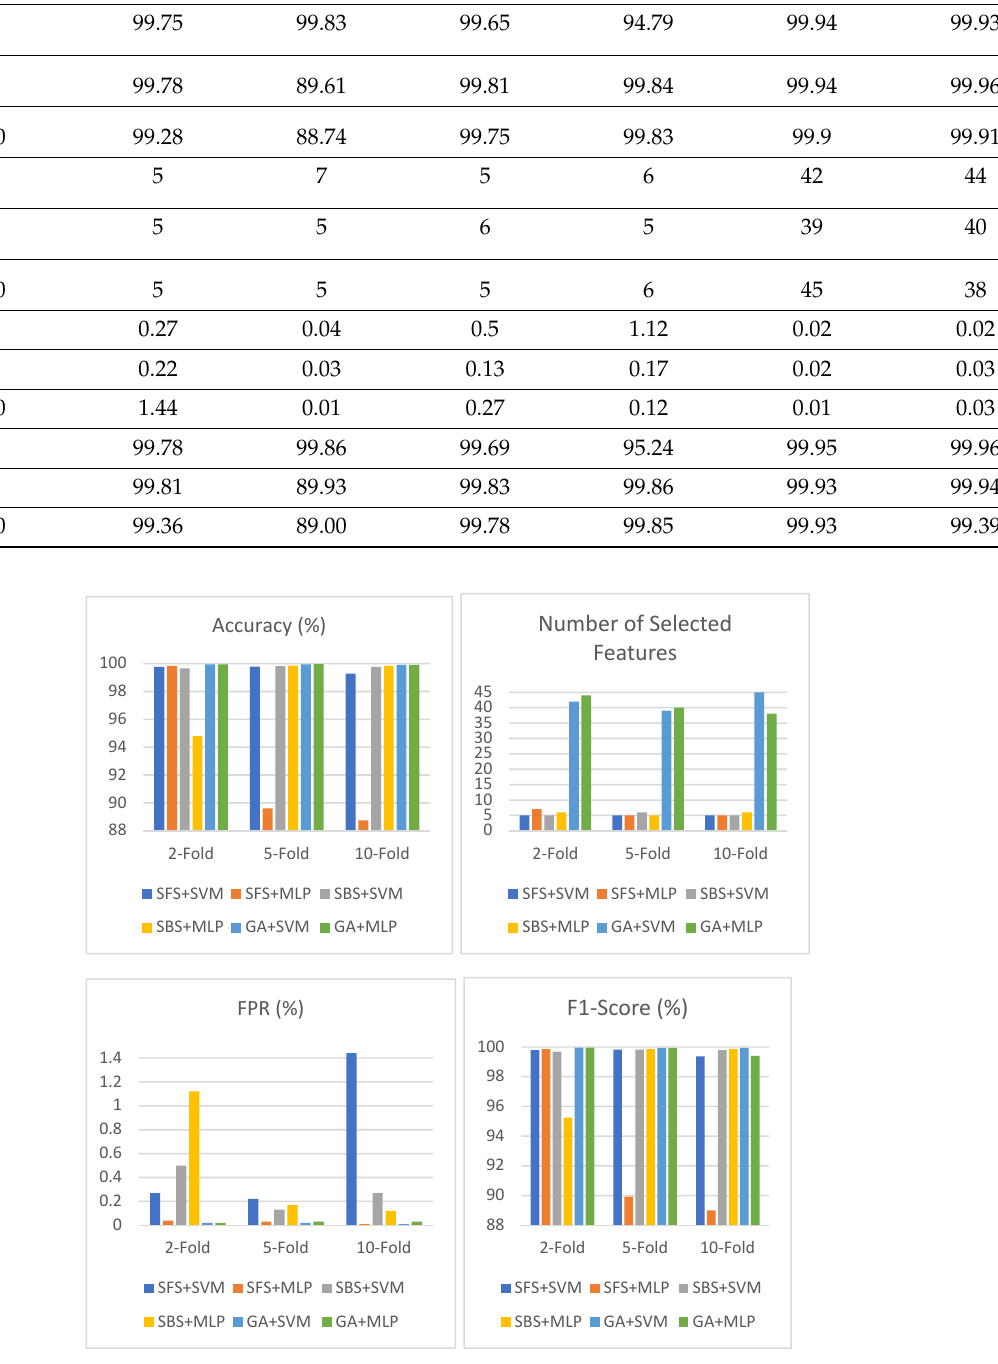
Figure 7. Performance of SFS, SBS, and GA using objective function based on accuracy and number of selected features in CIC-IDS-2017.